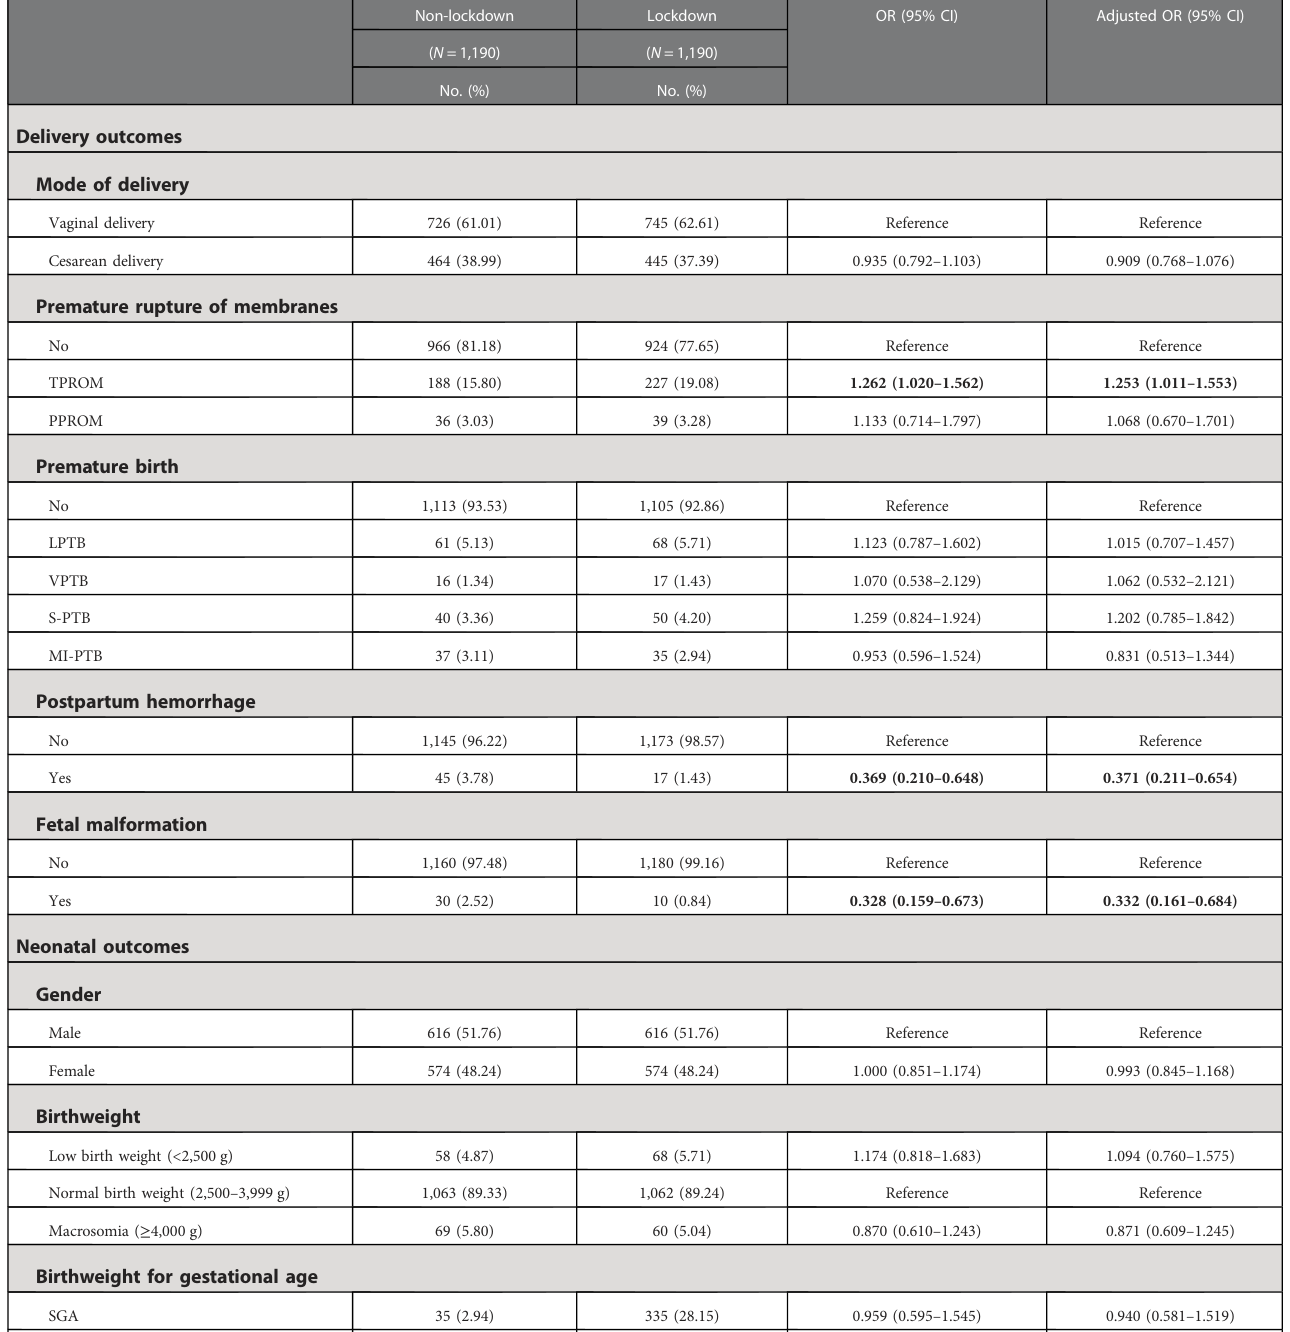
TABLE 4 Delivery outcomes and neonatal outcomes of PSM